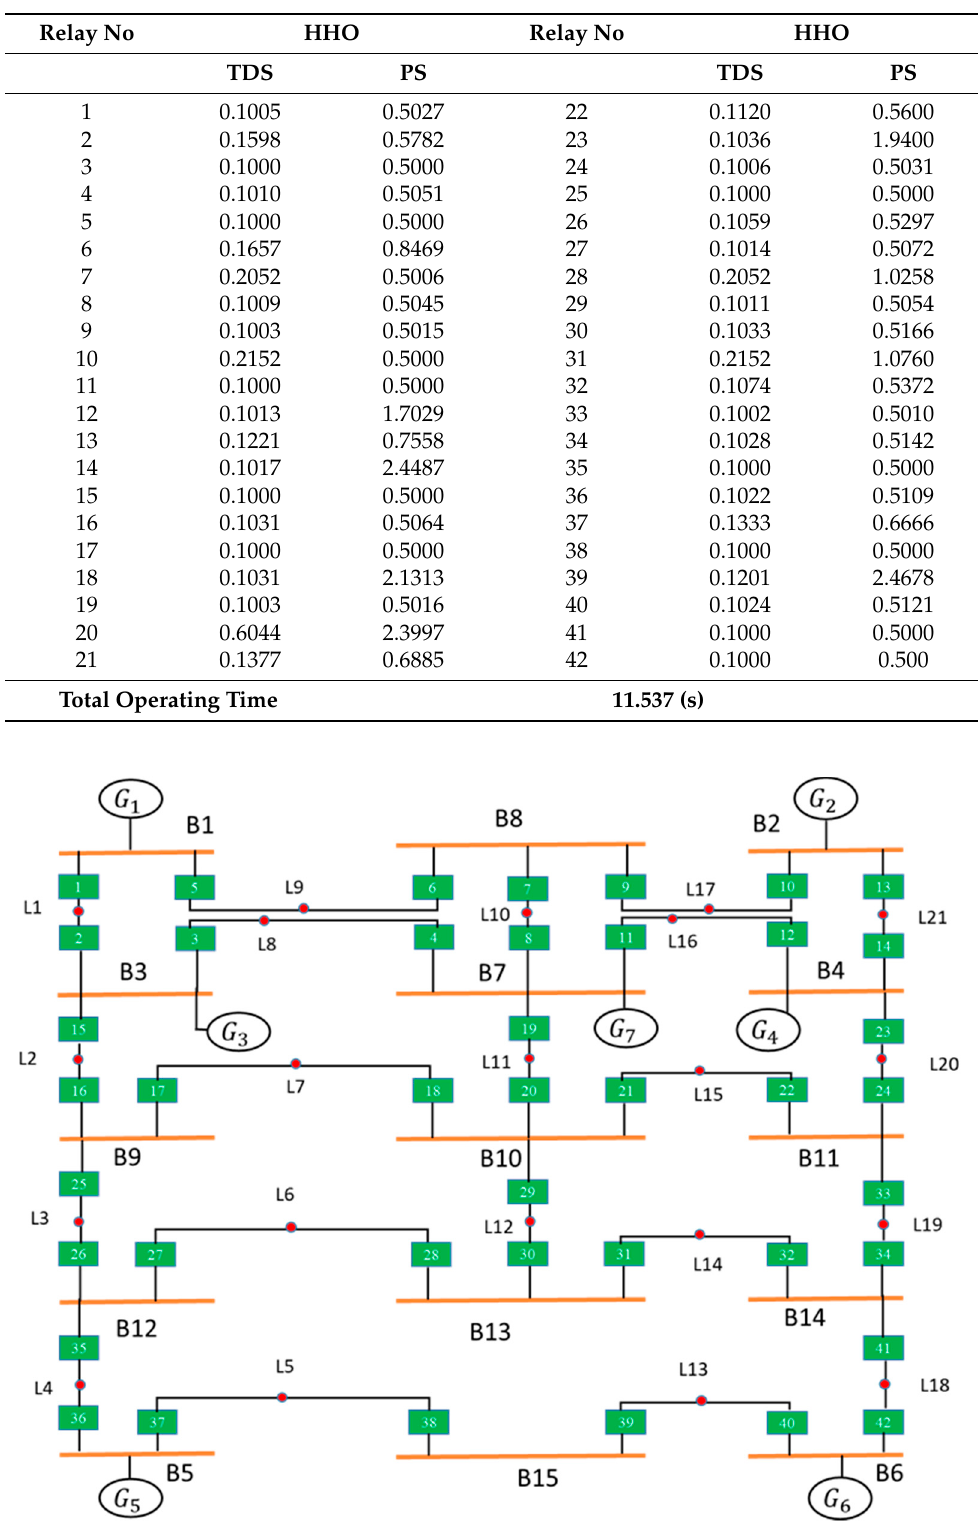
Table 5. Optimum values of TDS for the IEEE 15 bus system.